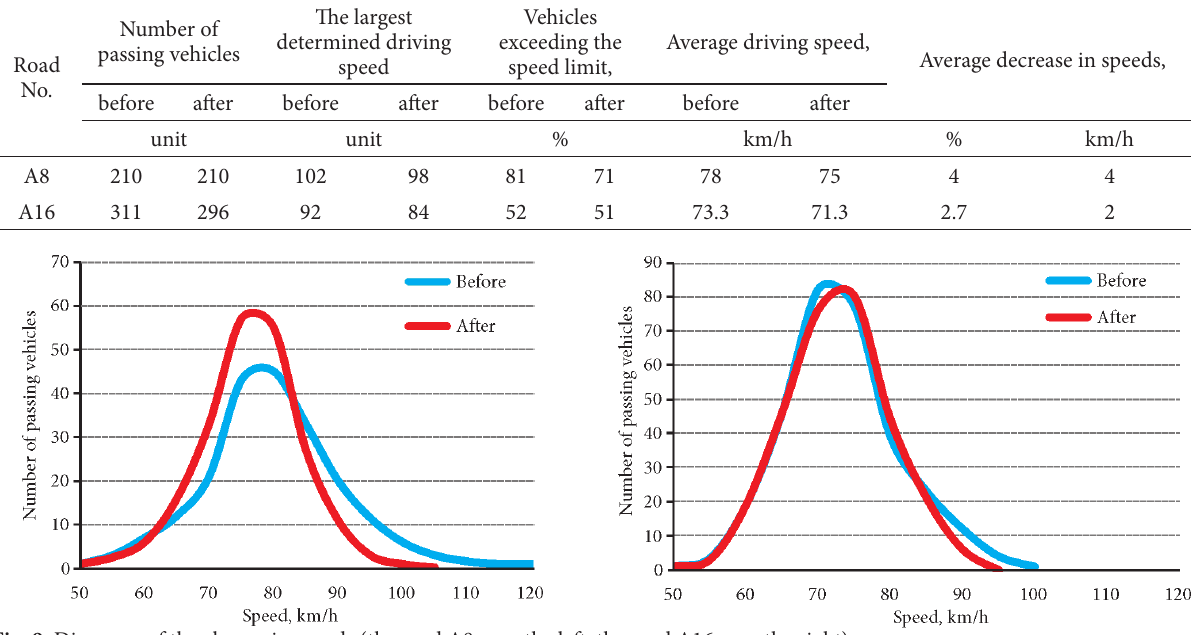
Fig. 9. Diagrams of the change in speeds (the road A8 – on the left, the road A16 – on the